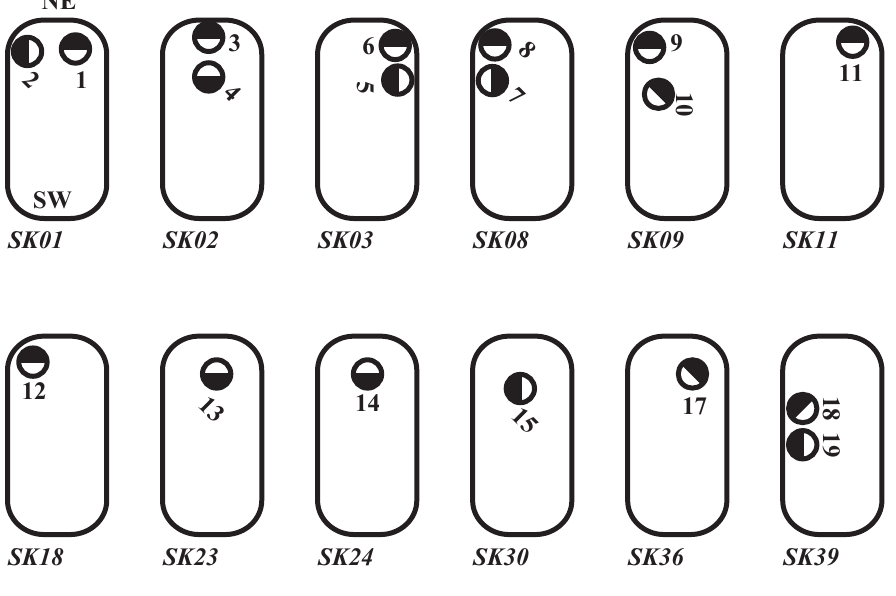
Figure 7. Schematic depiction of dedicated vessels in rectangular pit-graves in the Early Yayoi cemetery of the Mochida-Cho San-Chome site. The circle with shade means vessel with a fire-cloud or a discoloration; shade suggesting the direction of a fire-cloud. The number of each vessel corresponds to that of table 1. The vessel in an oblique position is indicated by an inclined number, and that in a lying position is indicated by a laid number. In most vessels that were deposited closely to the centre of the pit, a fire-cloud faced the dead body, while in the vessels deposited either alongside the wall or at the corner, a fire-cloud faced the